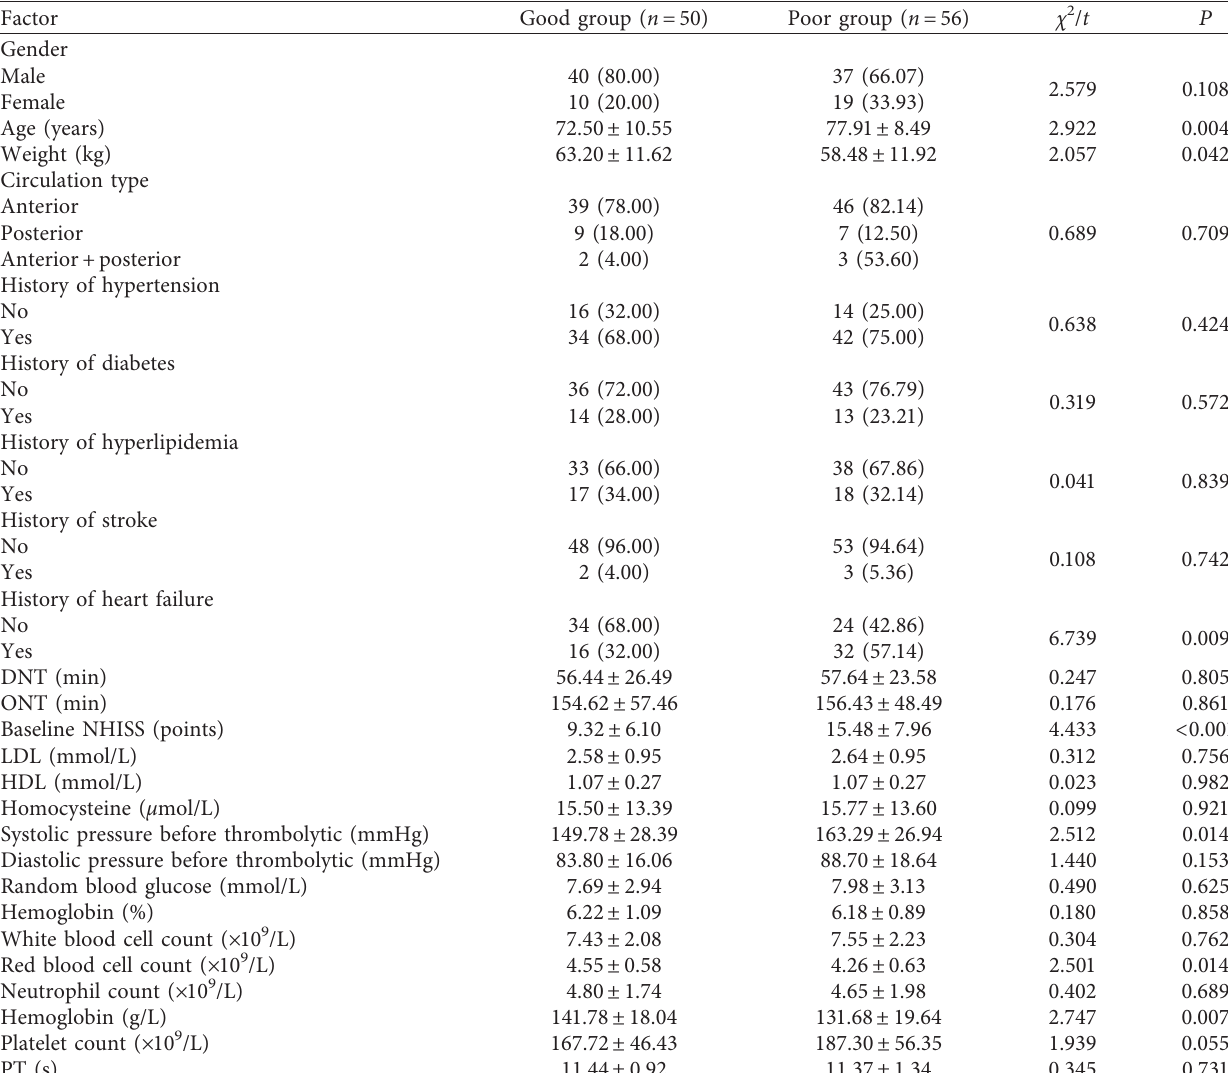
Table 3: Single factor analysis of intravenous thrombolysis of alteplase in ICS patients with atrial fibrillation.